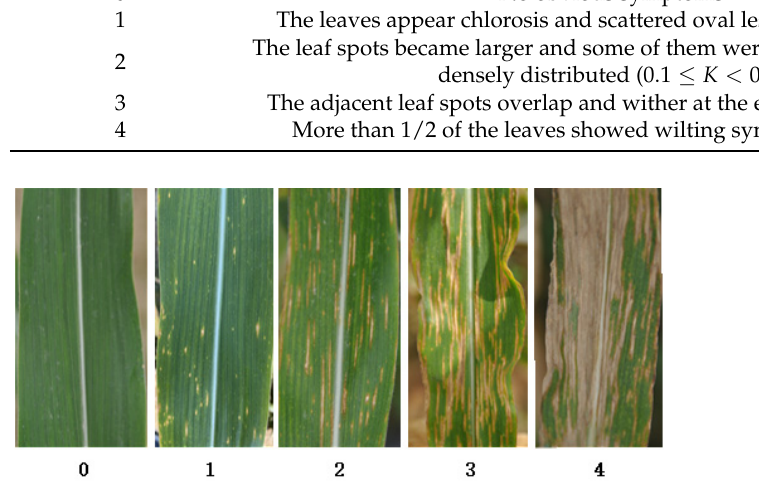
Figure 2. Level image